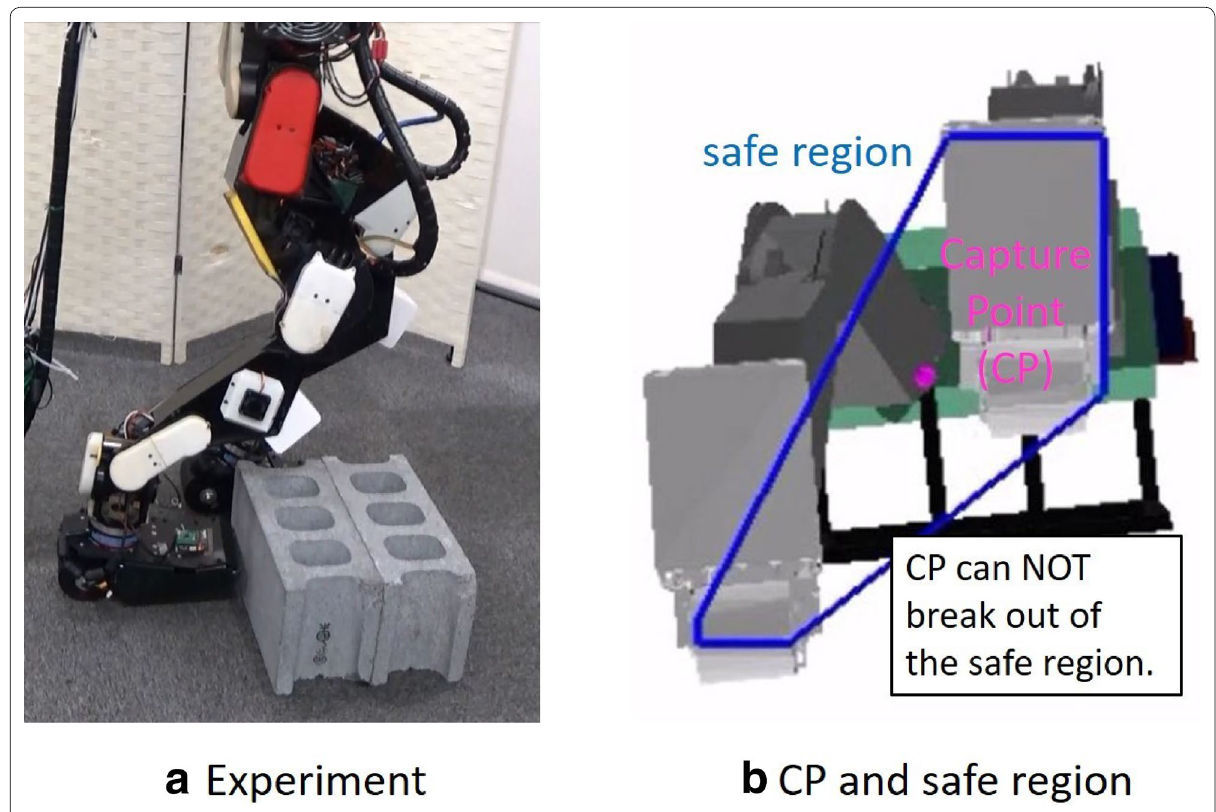
Fig. 9 Problem of